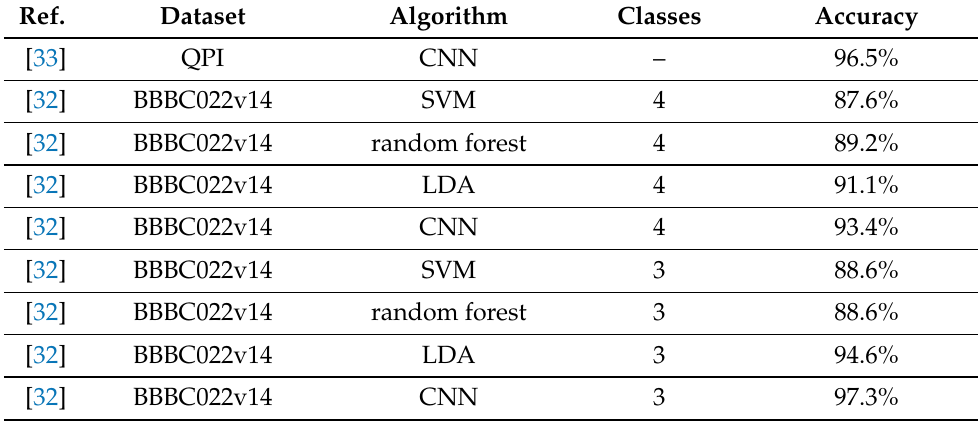
Table 2. Single cell classification.